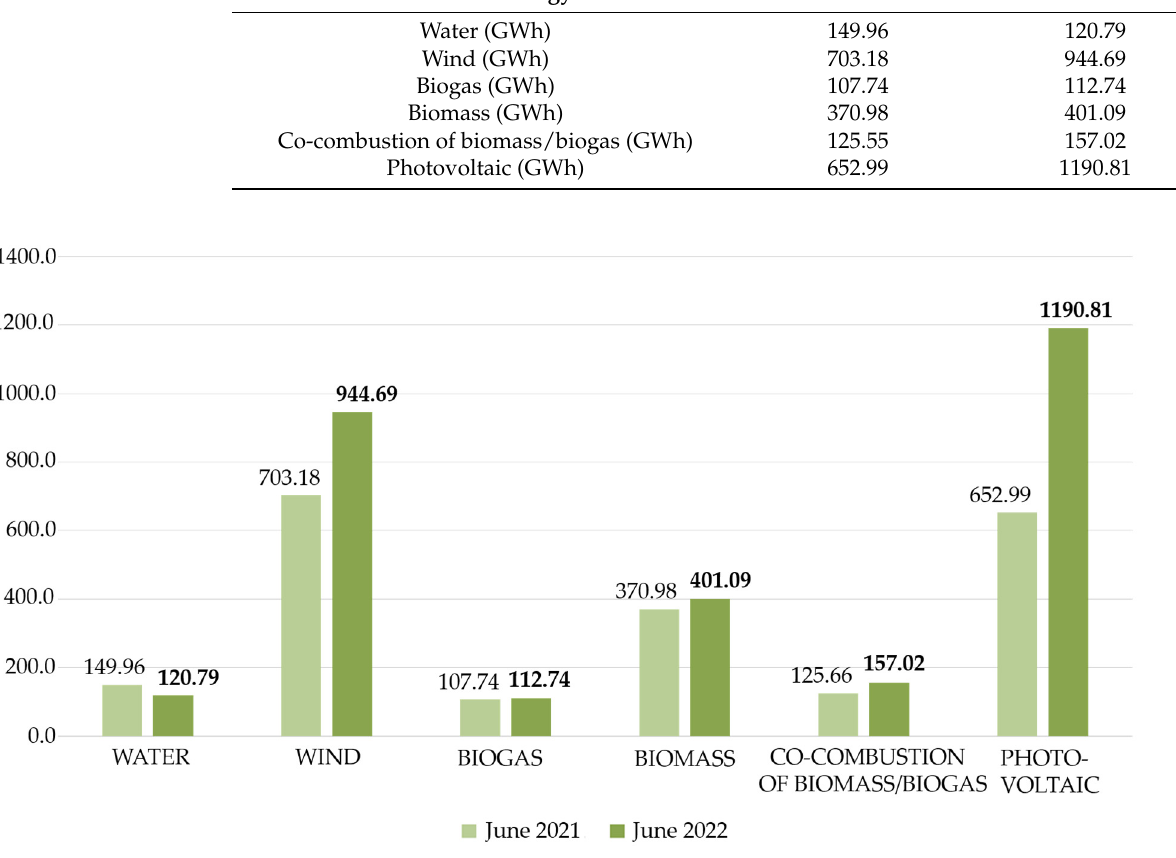
Figure 4. Juxtaposition of the electricity production from RESs in GWh in June 2021 and